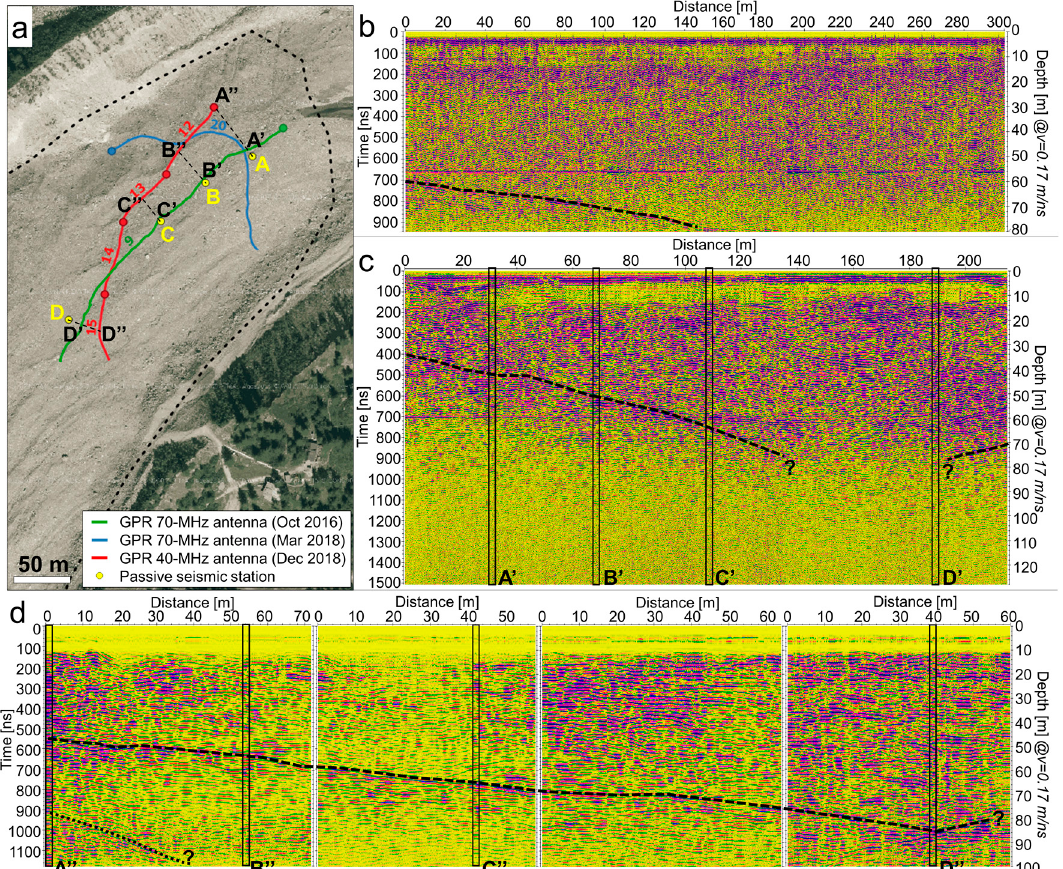
Figure 5. GPR results (same as Figure 4) with glacier bottom interpretation. The ice bottom morphology is highlighted in the radargrams with the dashed black lines. The possible bedrock top is underlined in ( d ) with the dotted black line. The approximate location of single-station passive measurements projected on the GPR profiles is shown in ( a ) with letters A’ to D’ (on 70-MHz profile 9) and A’’ to D’’ (on 40-MHz profiles 12 to 15), and in ( c ) and ( d ) with the black rectangles, for further comparison between GPR and HVSR results.